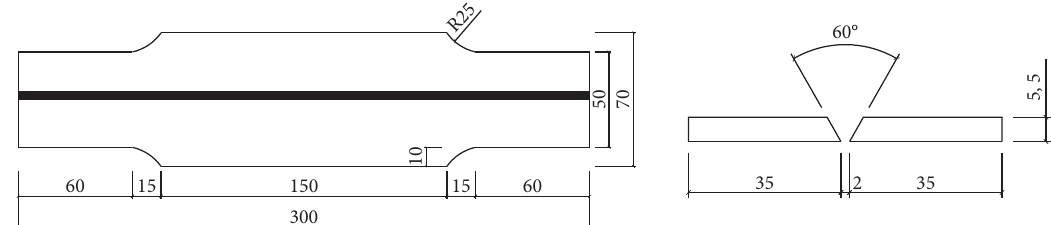
Figure 9: Welding specimen and groove